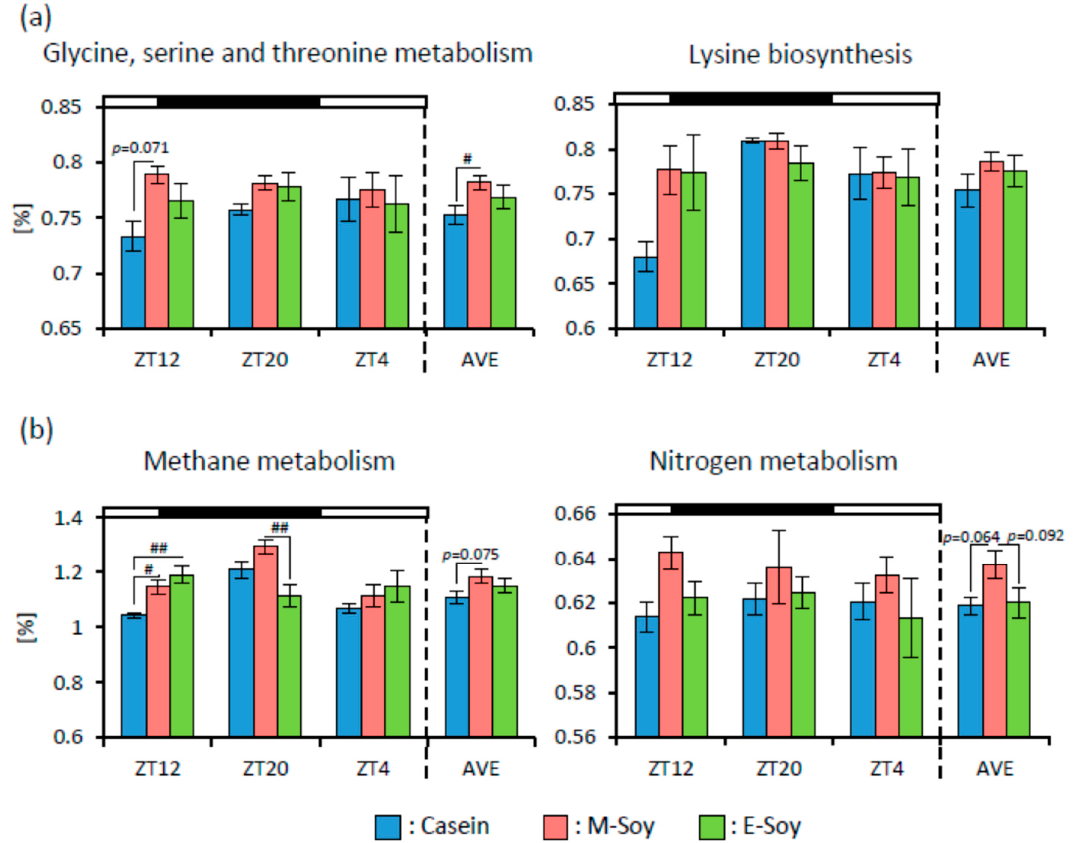
Figure 9. The functional predictions of microbial communities. ( a ) The functional predictions about categories related to “Amino Acid Metabolism” and ( b ) “Energy Metabolism” of microbial communities in mice that were kept under each feeding condition for two weeks (ZT12, ZT20, ZT4, and an average of three points). Data are represented as mean ± SEM ( n = 5). # p < 0.05, ## p < 0.01 evaluated using one-way ANOVA with Tukey’s post-hoc test.